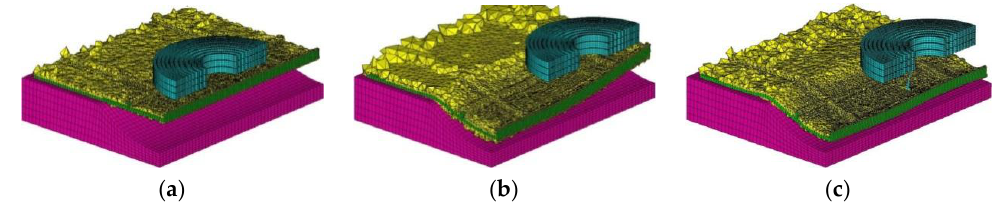
Figure 9. Air meshes at different moments: ( a ) initial; ( b ) deformation after the first station; and ( c ) deformation after the second station.